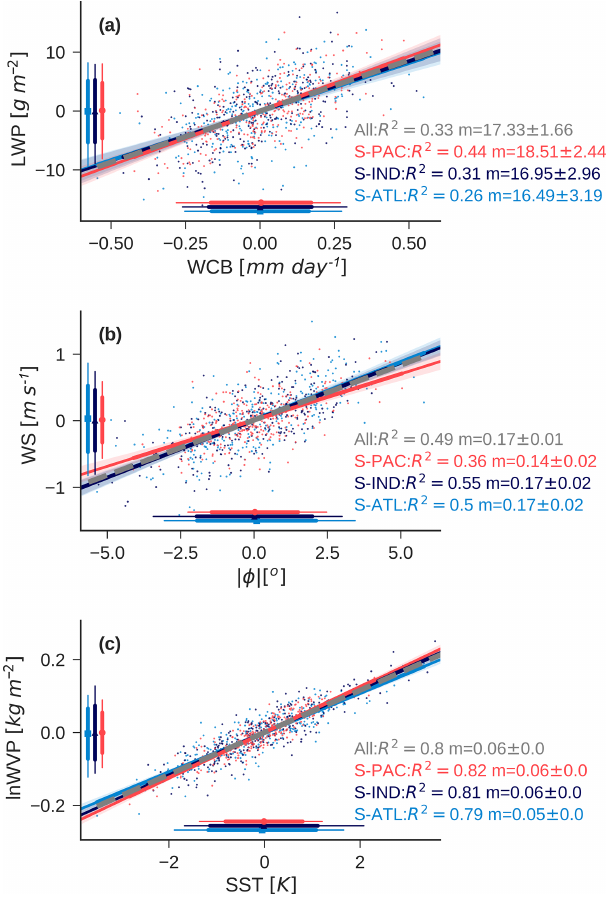
Figure 2. Observed monthly- and regional-mean anomalies in ex- tratropical cyclone properties in the SH oceans (NH oceans are shown in Fig. S5). (a) Cyclone monthly-mean LWP RM as a function of WCB RM ; (b) regional- and monthly-mean wind speed as a func- tion of regional- and monthly-mean cyclone absolute (poleward) latitude; (c) monthly-mean ln(WVP) RM as a function of SST RM . Each data point in the plot represents the monthly- and regional- mean anomaly in a given variable within extratropical cyclones rela- tive to the monthly-mean climatology. The shaded area corresponds to the 95% confidence interval on the fit. The R 2 and best fit line are listed for each subplot and for each ocean region. The R 2 of all monthly- and regional-mean anomalies is also noted (the variability in regional- and monthly-mean anomalies is weighted equally be- tween regions to calculate the overall R 2 ). Bars on the sides of the plot show the mean (marker), standard deviation (thick lines), and 90th percentile range (thin lines) of monthly- and regional-mean anomalies for each